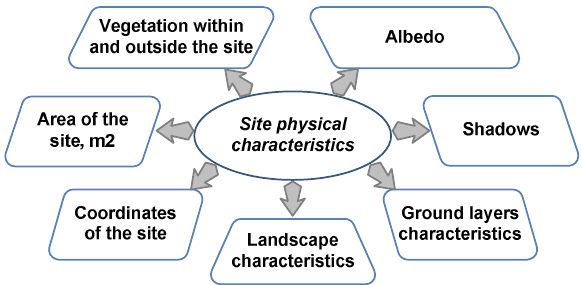
Fig. 5. Structure of building site’s physical